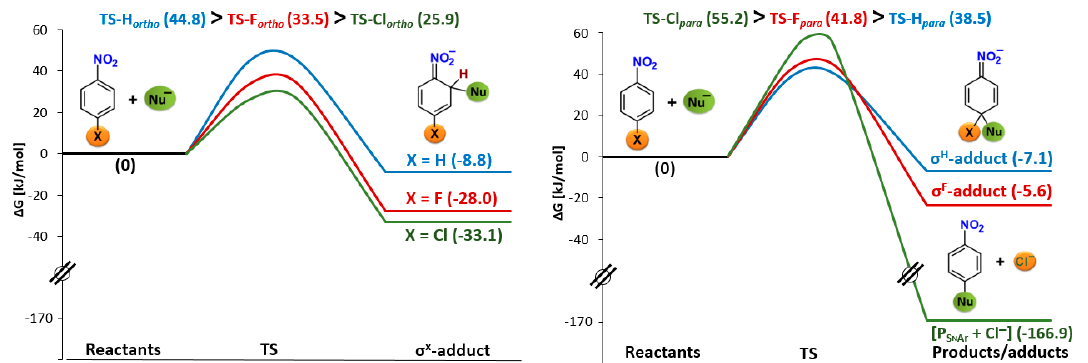
Figure 1. Potential energy profiles for the limiting step of S N Ar-H ( left ) and S N Ar-X ( right ) reactions between model nuclephile 1 and para substituted halonitrobenzenes constructed based on our previous computation results published elsewhere